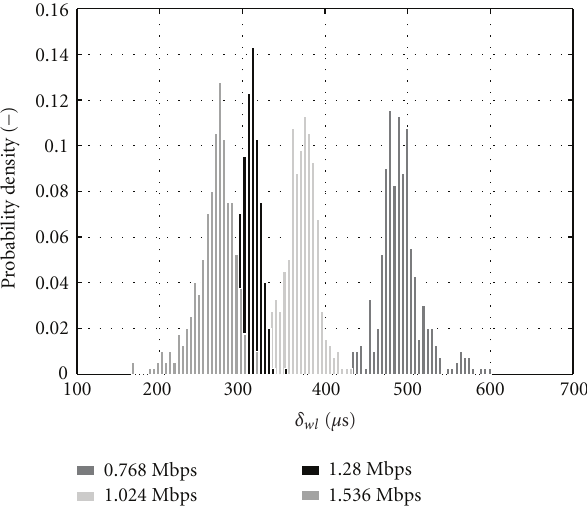
Figure 10: Measured additional closed loop delay probability density at di ff erent data rates.